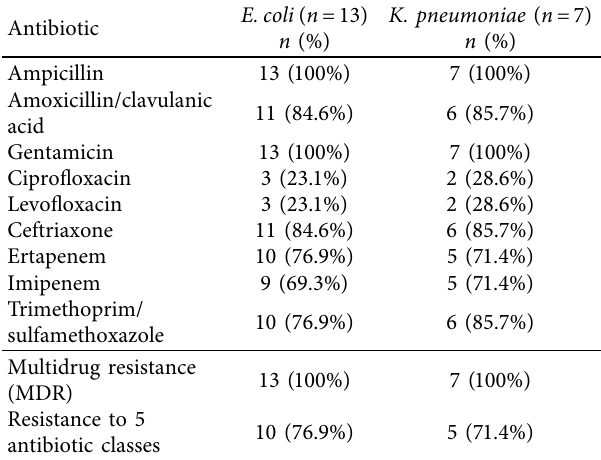
Table 3: Antimicrobial susceptibility pattern of E. coli and K. pneumoniae isolated from infected open